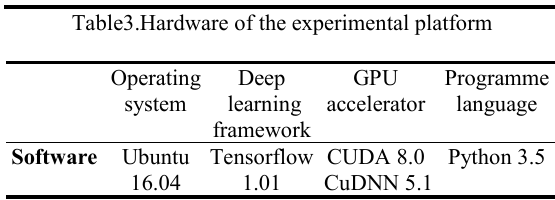
Table 4. Software of the experimental platform